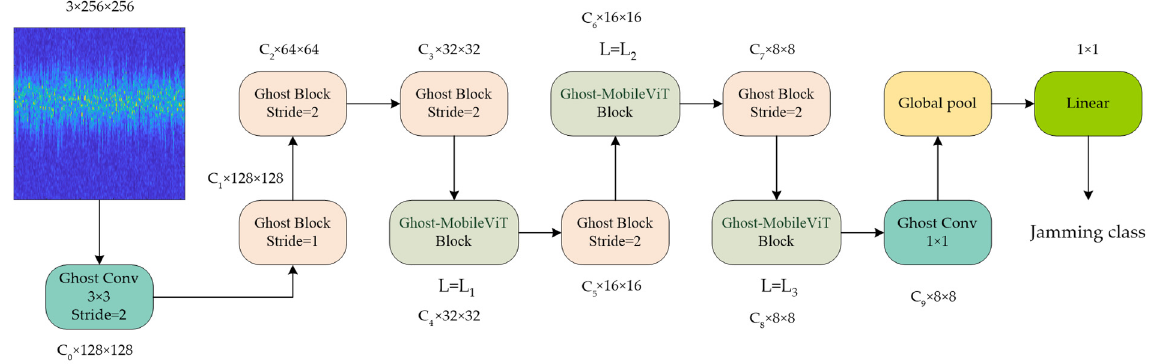
Table 2. Parameter settings of JR-TFViT_S, JR-TFViT_M, and JR-TFViT_L.